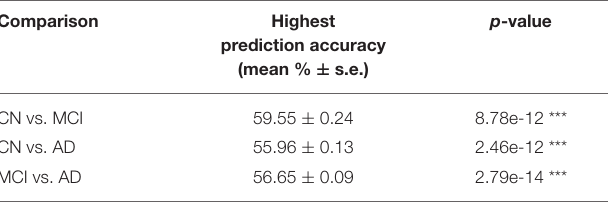
TABLE 3 | Highest prediction accuracy for Alzheimer’s Disease Neuroimaging Initiative (ADNI) data using differentially expressed genes from National Neuroscience Institute (NNI) data as predictive